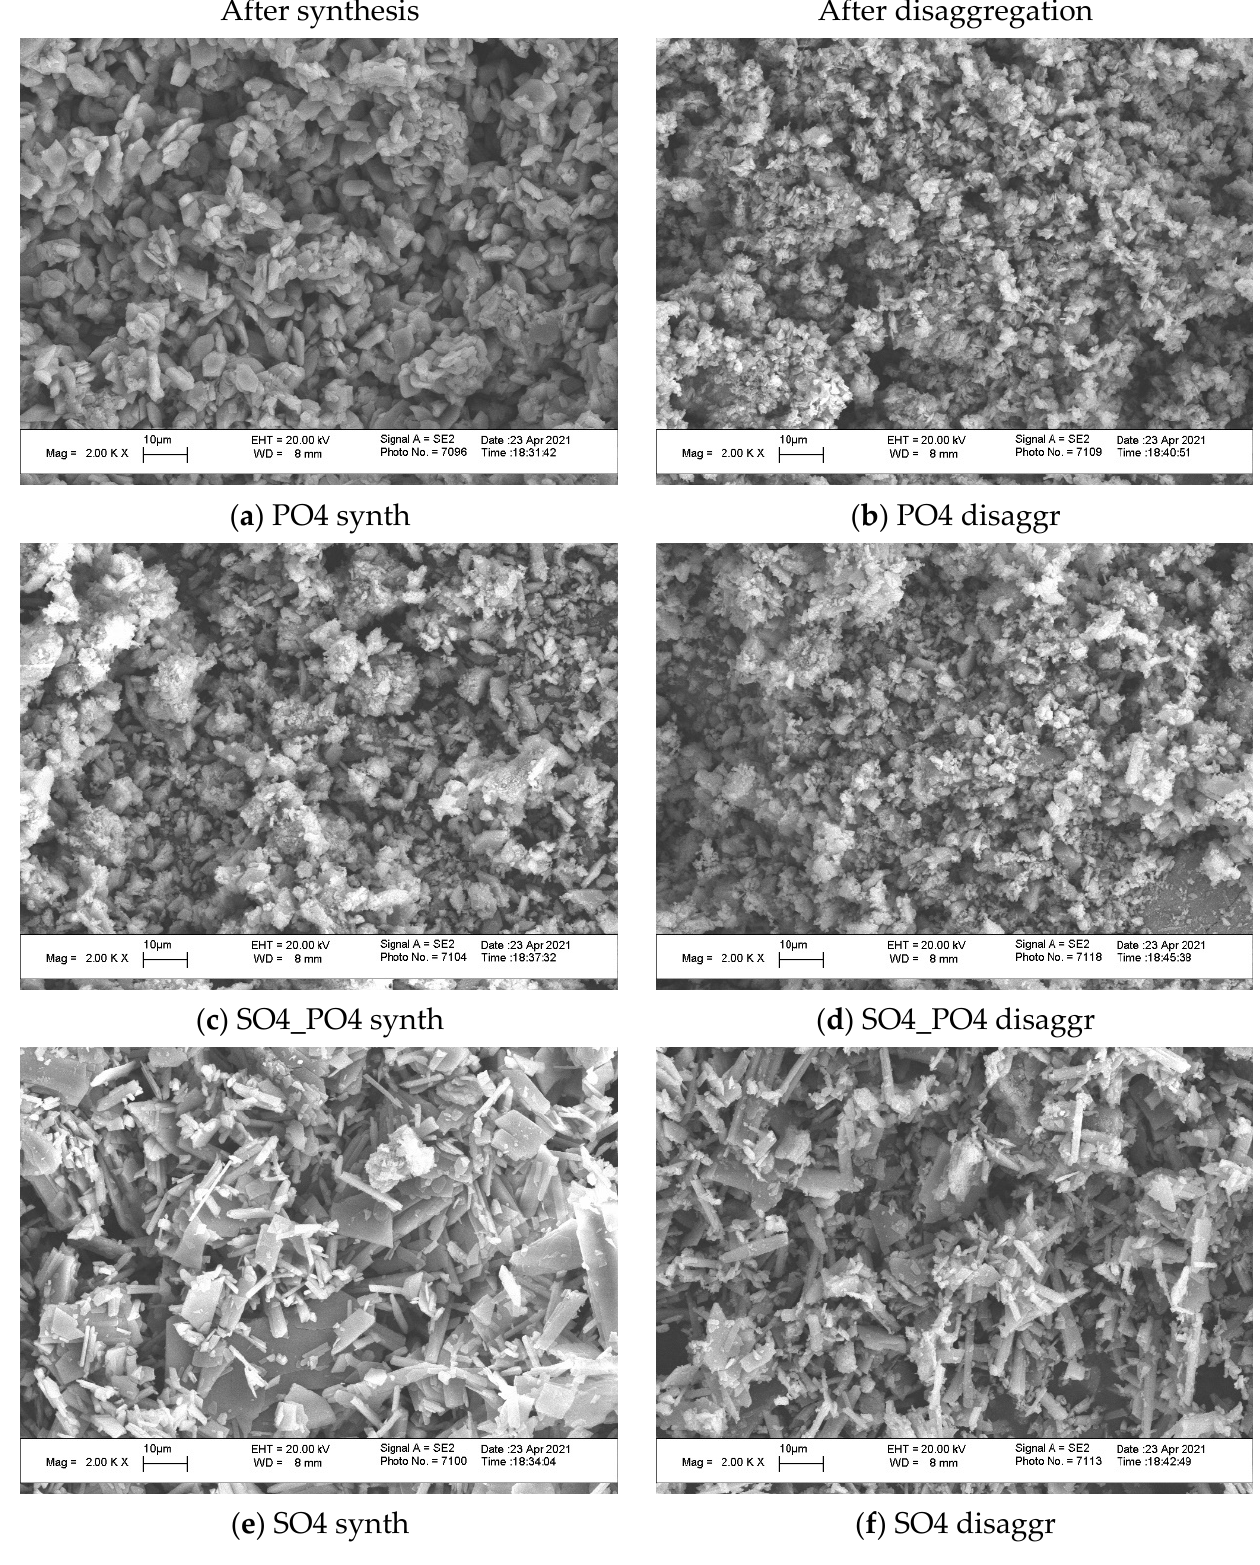
Figure 5. SEM images of powders after synthesis (left column, ( a , c , e )) and after disaggregation in acetone (right column ( b , d , f )).